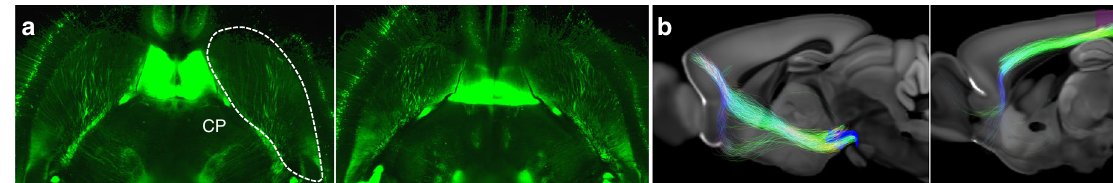
CLARITY-based tracts, we again used our mPFC injections.